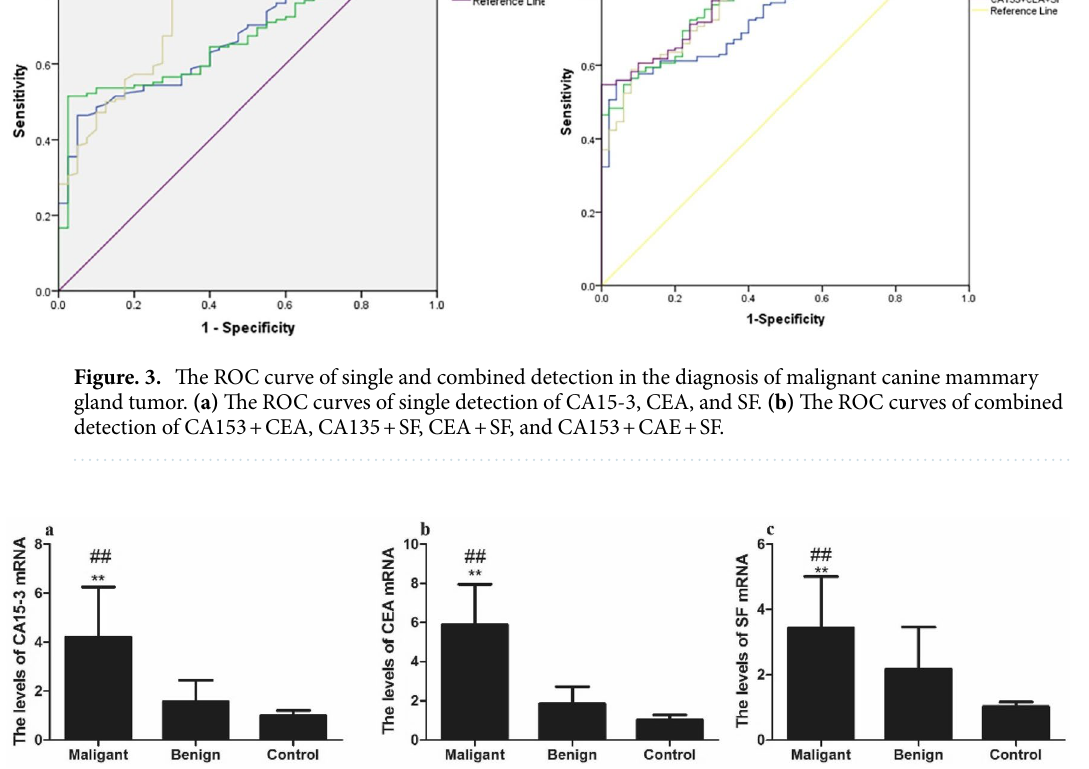
Figure. 4. Levels of tissue CA15-3, CEA and SF mRNA in canine mammary gland tumor. (a) Tissue CA15-3 mRNA levels of malignant tumor group, benign tumor group, and healthy control group. (b) Tissue CEA mRNA levels of the three groups. c. Tissue SF mRNA levels of the three groups. Note: * P < 0.05 showed significance difference, ** P < 0.01 showed extremely significant difference vs control group; Comparison